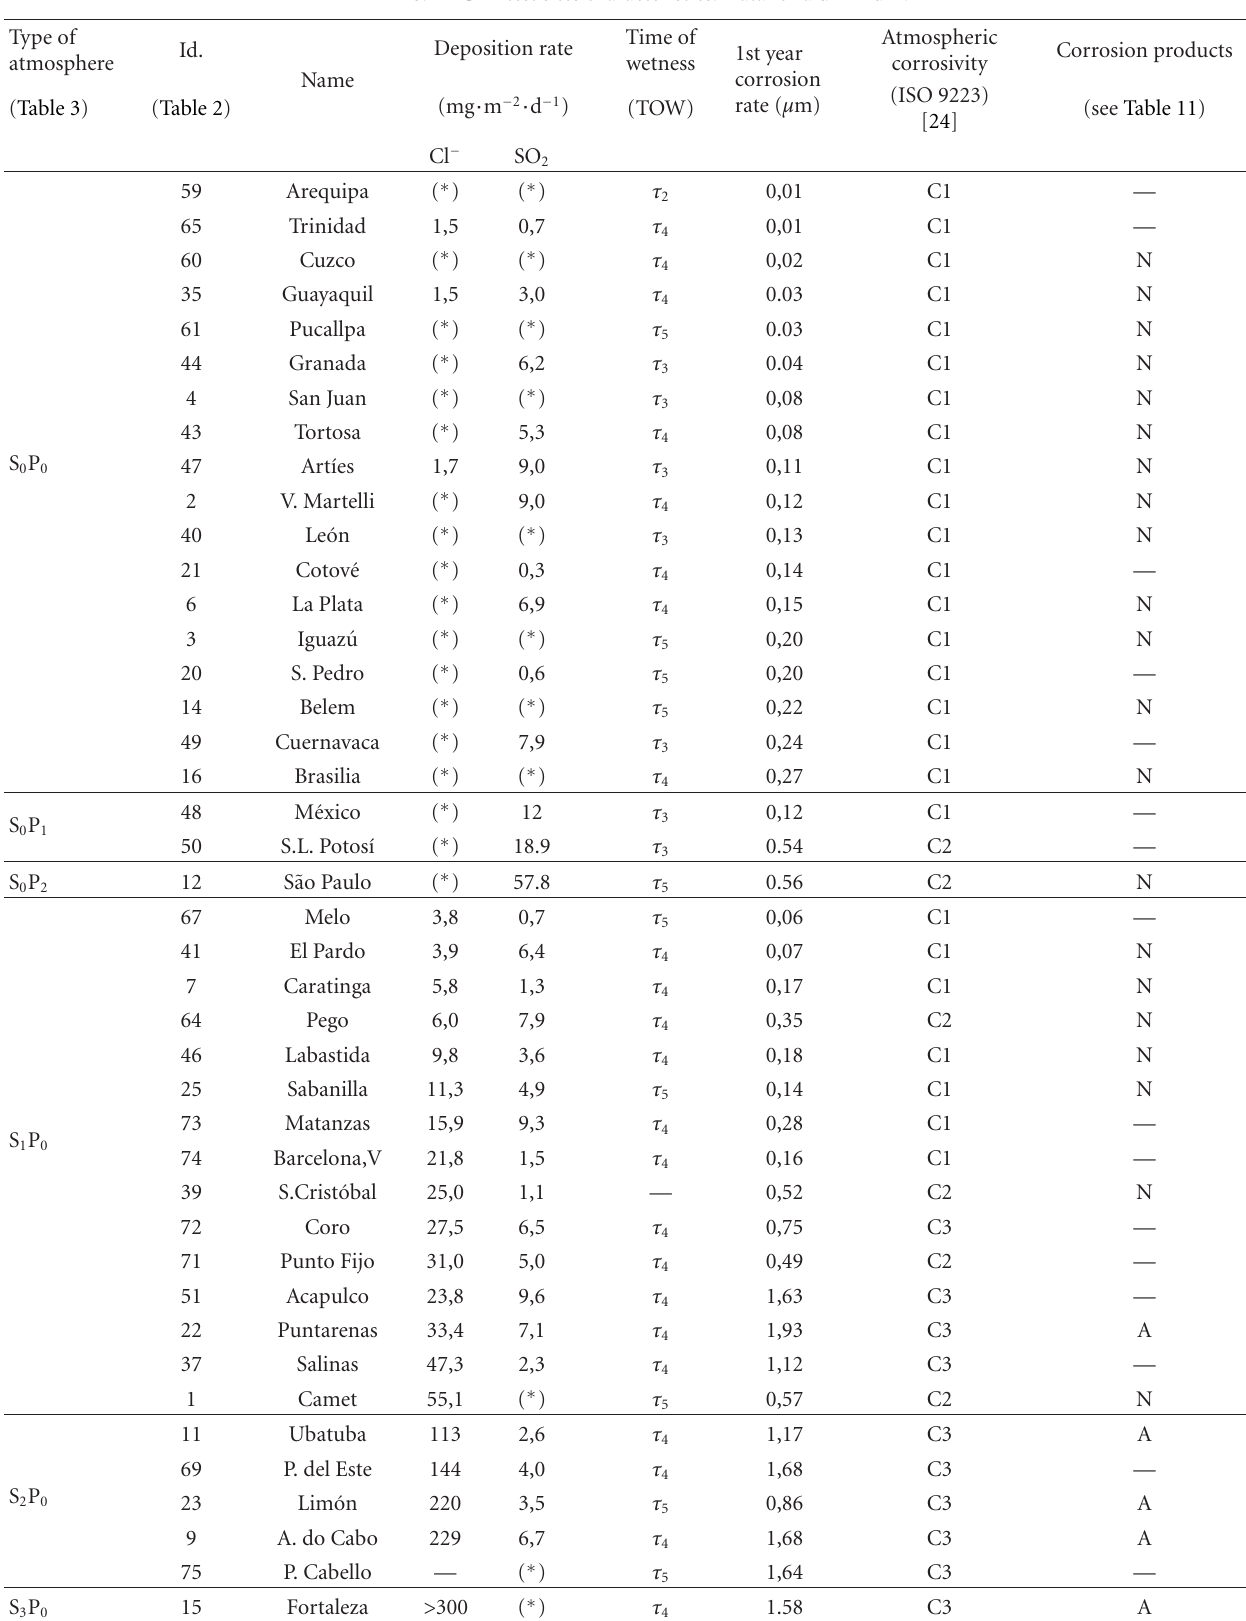
Table 10: MICAT test sites characteristics. Data for